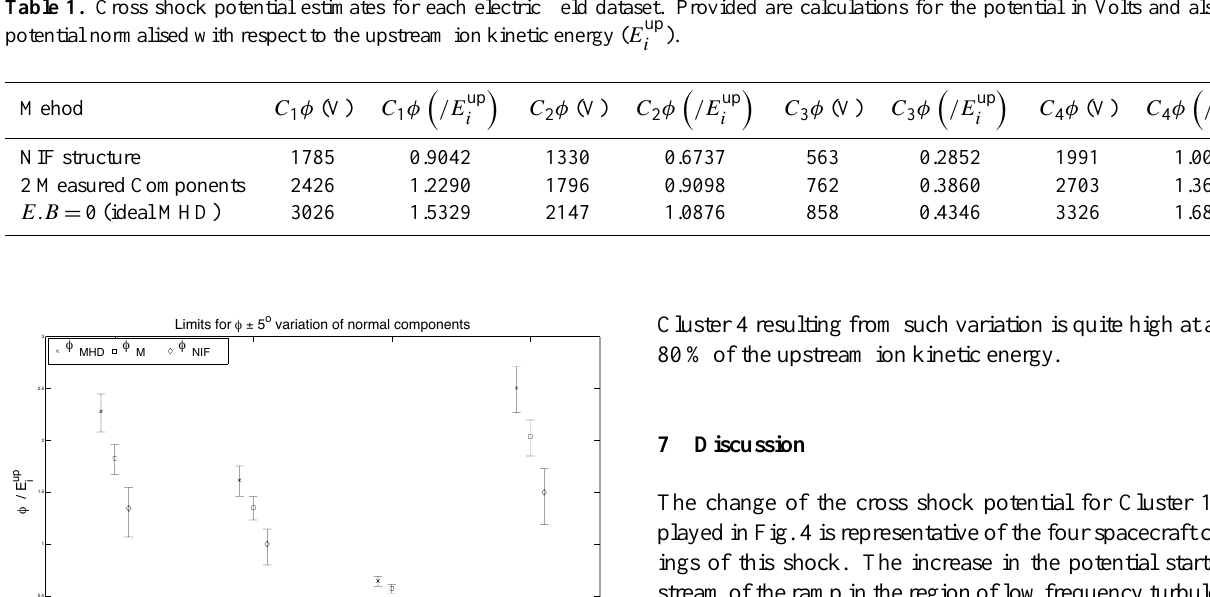
Table 1. Cross shock potential estimates for each electric field dataset. Provided are calculations for the potential in Volts and also the potential normalised with respect to the upstream ion kinetic energy ( E up